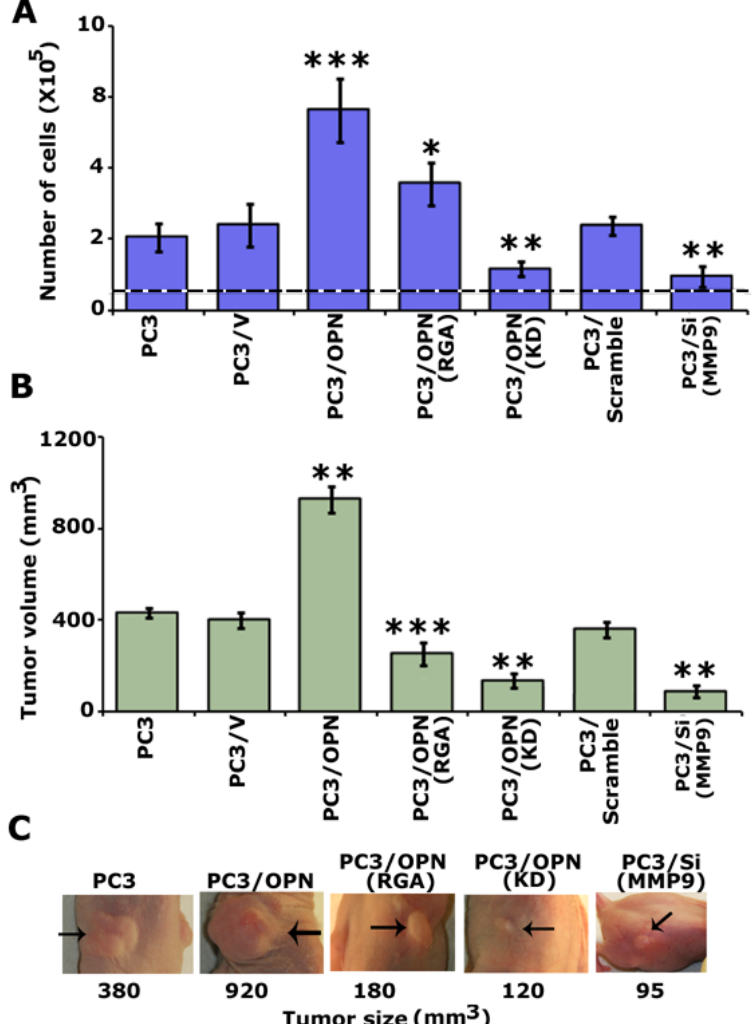
Figure S1. OPN over-expression increases proliferation of PC3 cells and the ability of these cells to form big tumor in nude mice. Cells at log phase of growth were used for proliferation assay in vitro in 48 well plates ( A ) and tumor growth experiment in vivo in nude mice ( B and C